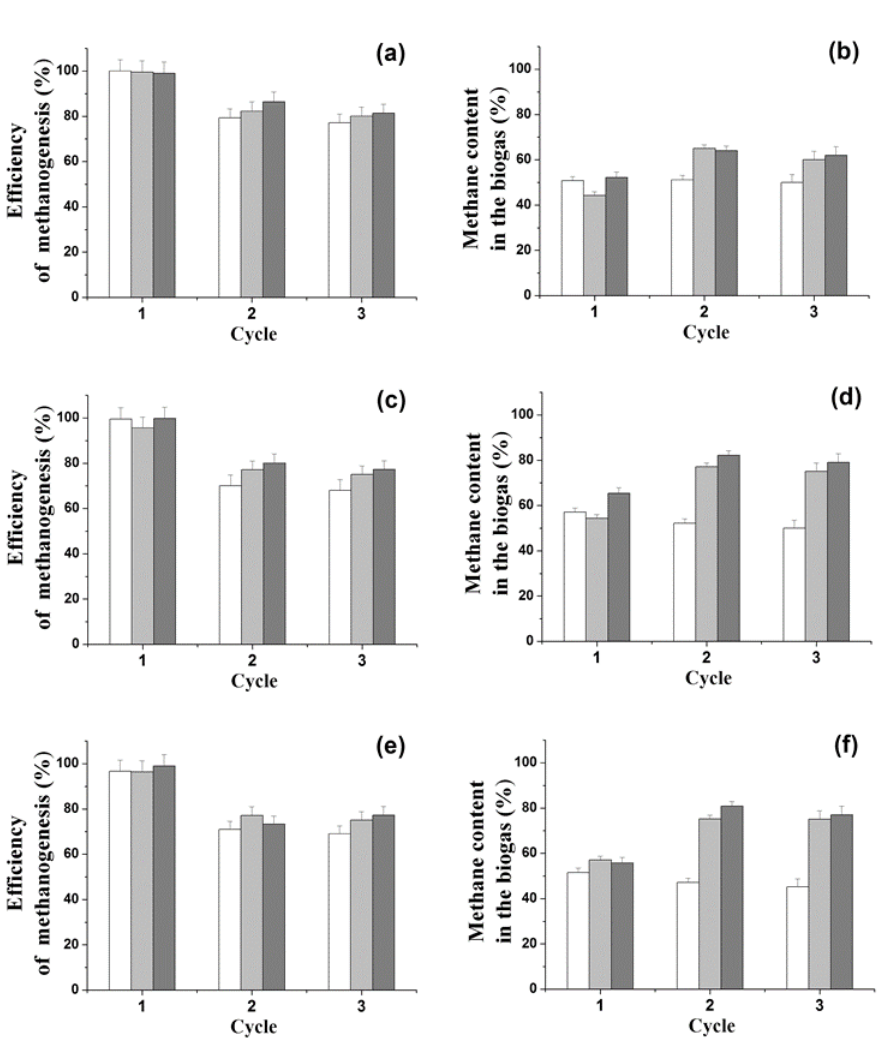
Figure 3. Efficiency of methanogenesis and amount methane in the biogas in the course of transformation of 1 g/L glucose in medium containing 0.15 mM BTO 2 ( a , b ), 0.15 mM DBTO 2 ( c , d ), or 0.45 mM DBTO 2 ( e , f ) under the action of different anaerobic biocatalysts immobilized in the PVA cryogel: 90% AS III + 10% D. vulgaris (white columns), 90% AS III + 10% C. acetobutilycum (light gray columns), 80% AS III + 10% D. vulgaris + 10% C. acetobutilycum (dark gray columns). The duration of each single working cycle was eight days. The immobilized biocatalysts were combined in specific mass ratios directly in the reaction medium.